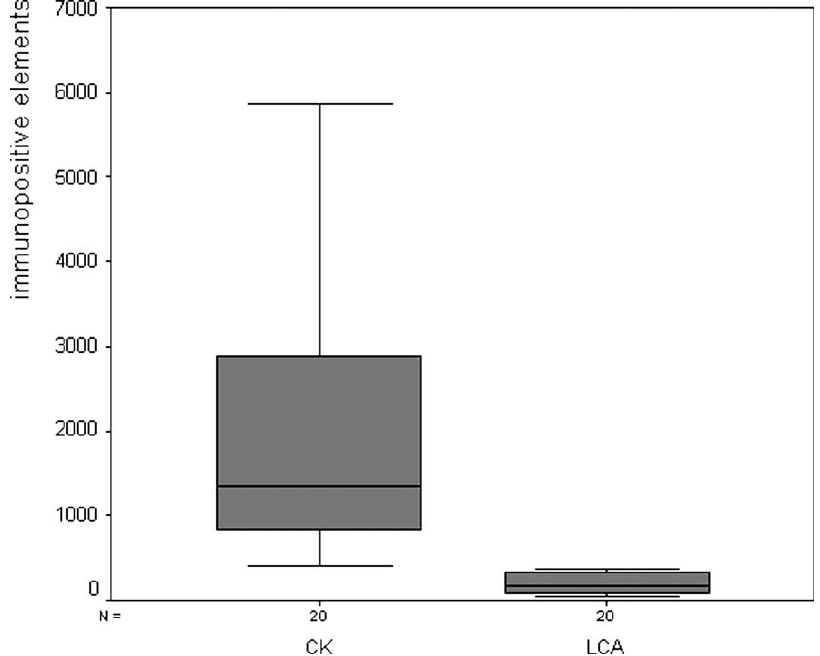
Fig. 6. Boxplot of the number of immunopositive tissue elements found in CK and LCA stained sections ( t -test: p < 0 . 001).